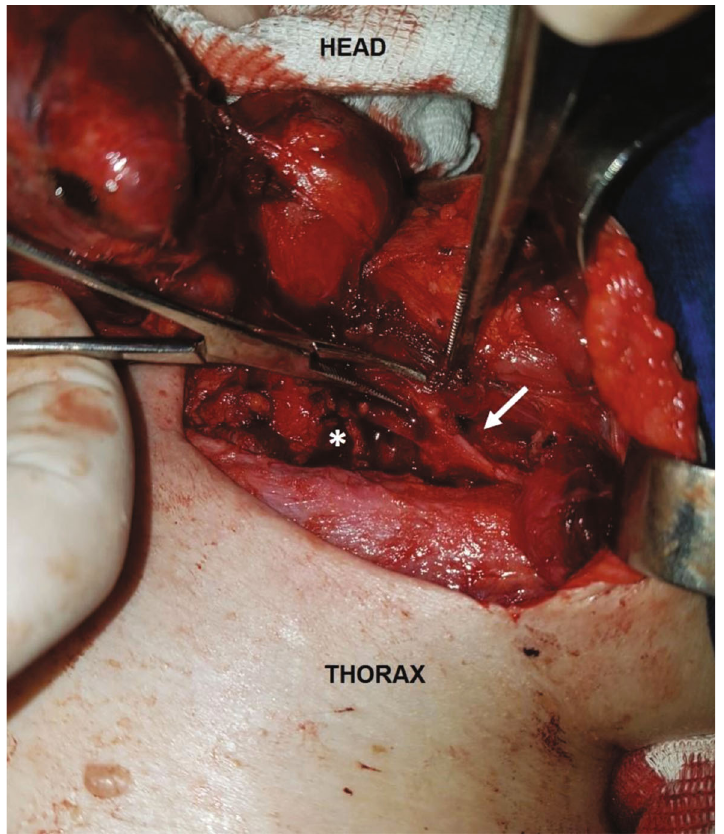
Figure 2: Surgical cervical exploration on the left nerve. Laryngeal nerve (arrow) out tracheoesophageal groove (asterisk), its usual anatomical